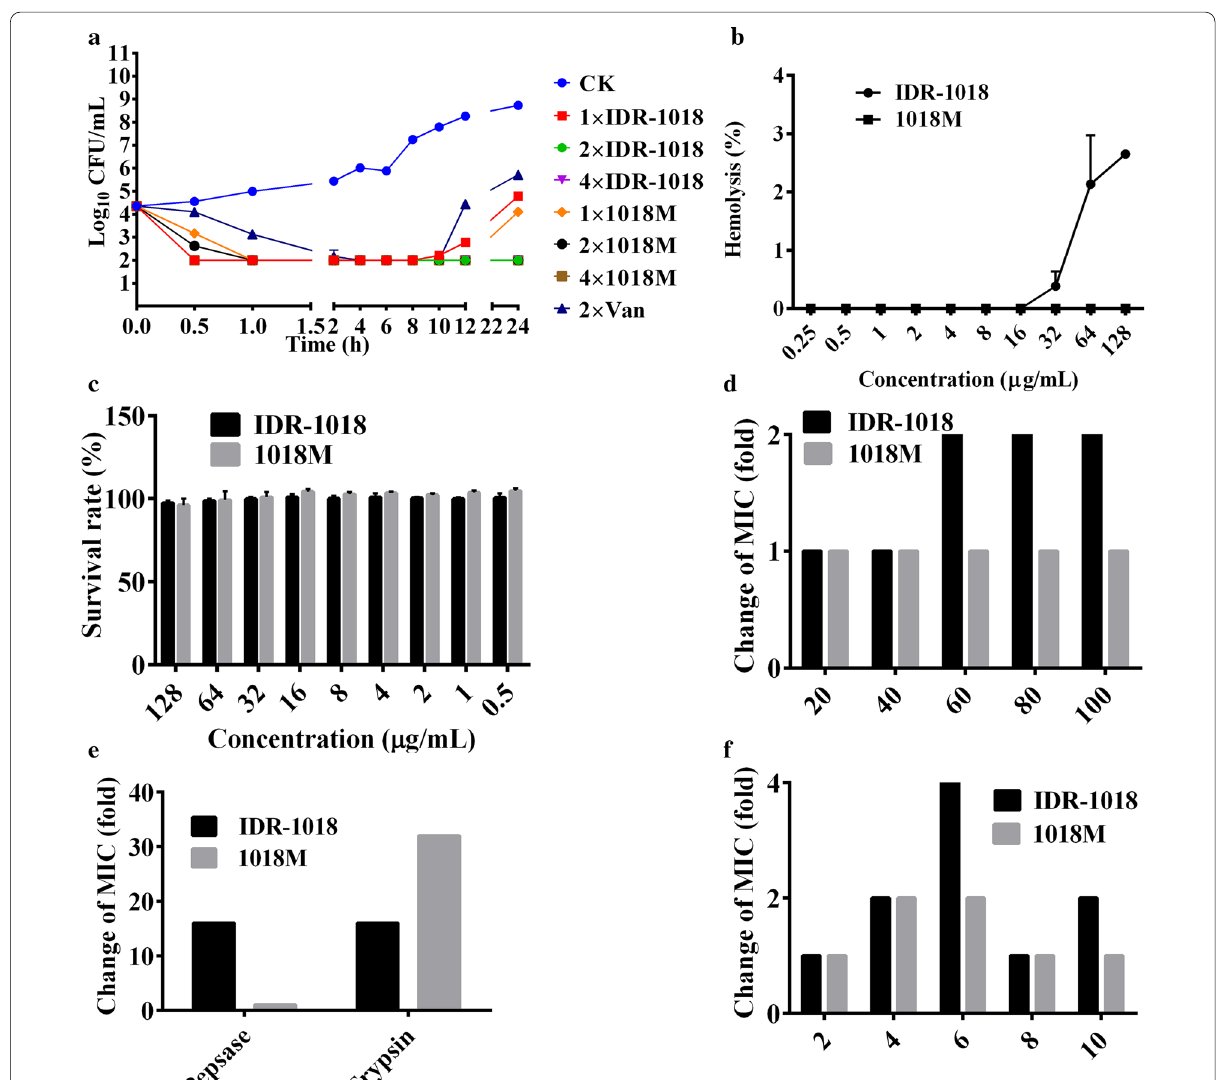
Fig. 2 The extracellular killing curves, toxicity and stability of 1018M. a Bactericidal kinetics assay of MRSA ATCC43300 treated with IDR-1018, 1018M and Vancomycin. b The hemolyses of 1018 and 1018M against the red blood cells of mice. c The cytotoxicities of 1018 and 1018M against the RAW 264.7 cells. d – f The temperature ( d ), protease ( e ) and pH ( f ) stability of IDR-1018 and